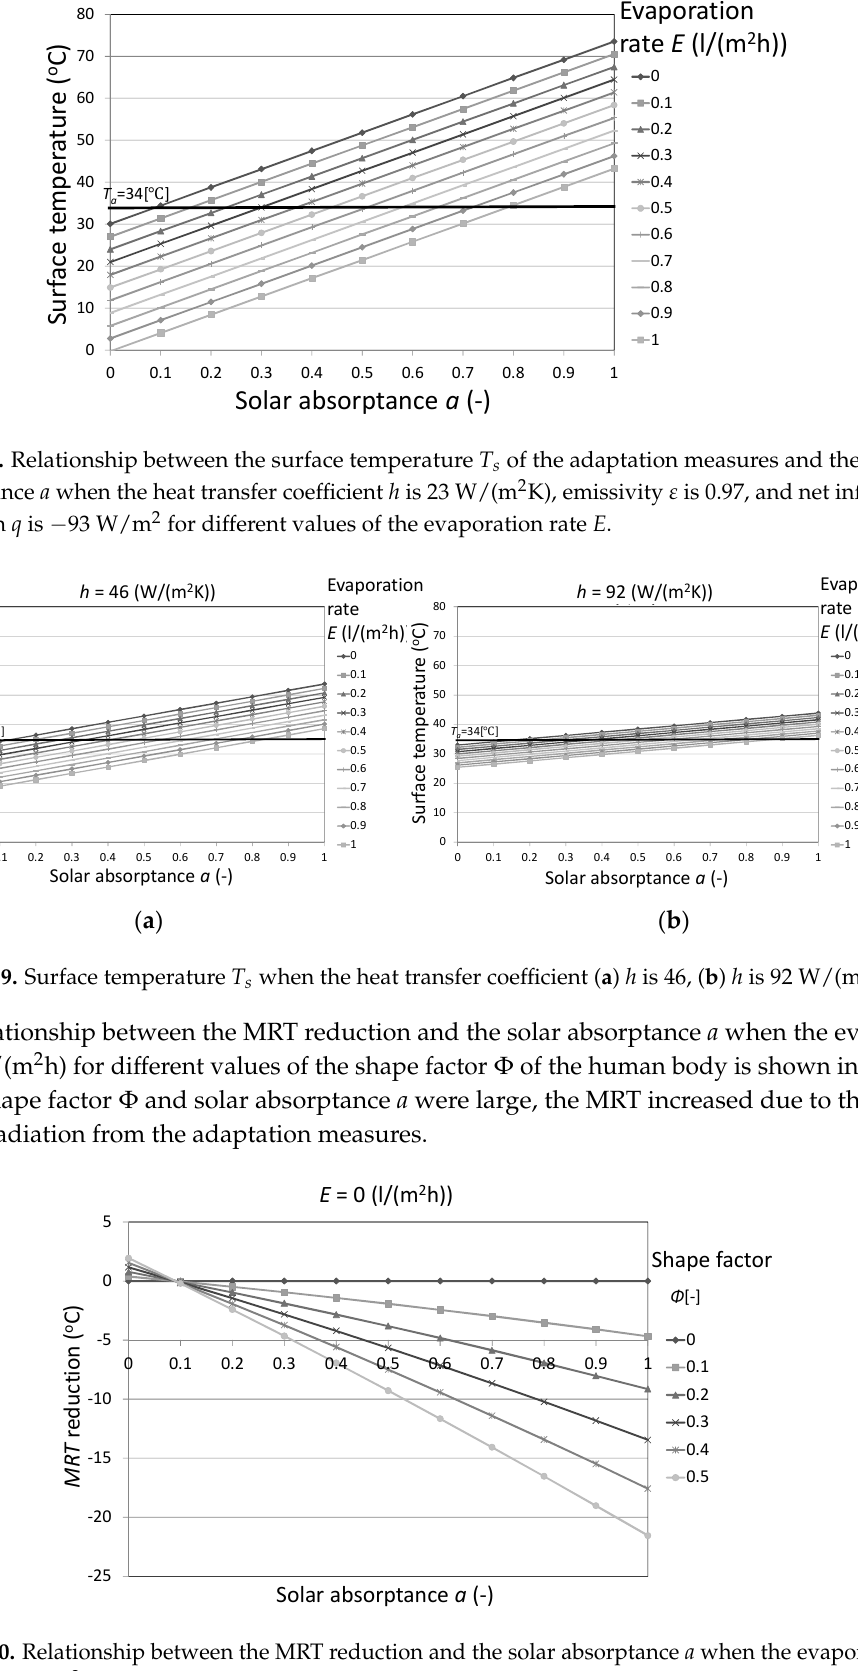
Figure 11. Relationship between the MRT reduction and the solar transmittance τ when the evaporation rate E is 0 L/(m 2 h) and the shape factor of the human body Φ is 0.3 for different values of the solar absorptance a . Figure 12. Relationship between the MRT reduction and the solar transmittance τ when the evaporation rate E is 1.0 L/(m 2 h) and the shape factor of the human body Φ is 0.3 for different values of the solar absorptance a .